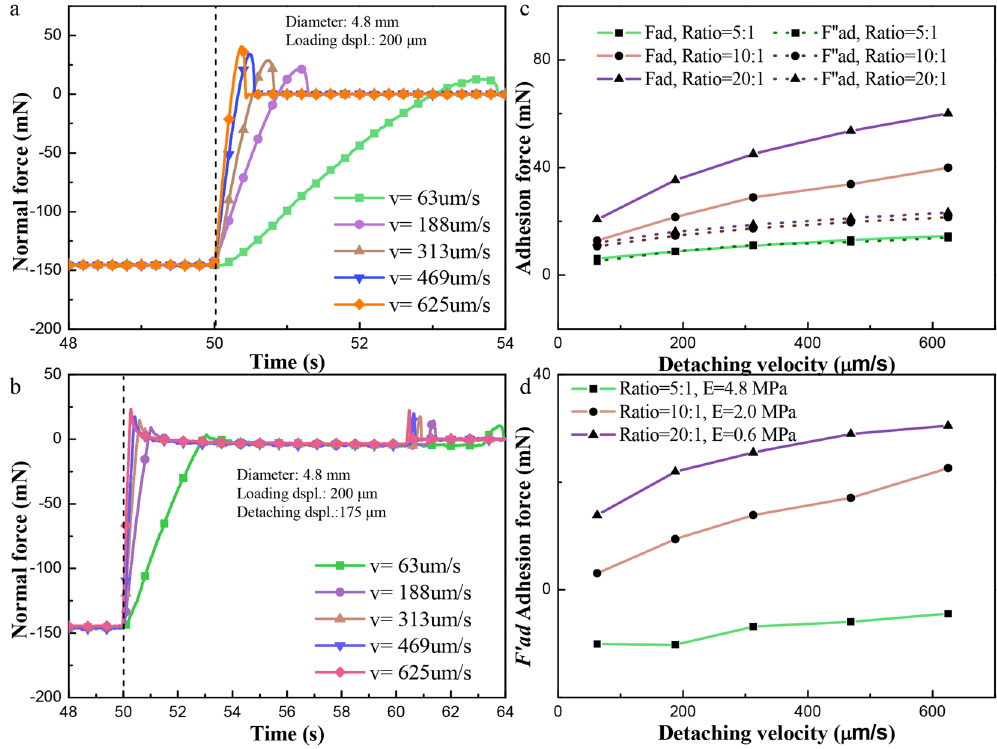
Figure 5. Normal force vs. time in OSD and TSD with different detaching velocities. ( a ) curve in OSD, totally detaching and a loading displacement of 200 μ m at different detaching velocities v (diameter D = 4.8 mm); ( b ) curve in TSD, first detaching displacement of 175 μ m and a loading displacement of 200 μ m with different detaching velocities v (diameter D = 4.8 mm).